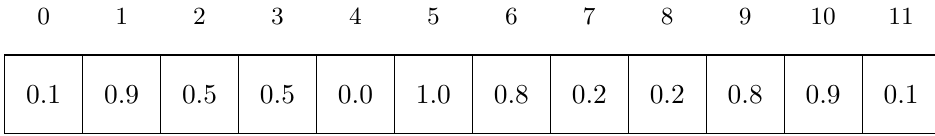
Figure 2. φ ( X 1 , X 2 , X 3 ) as 1DA